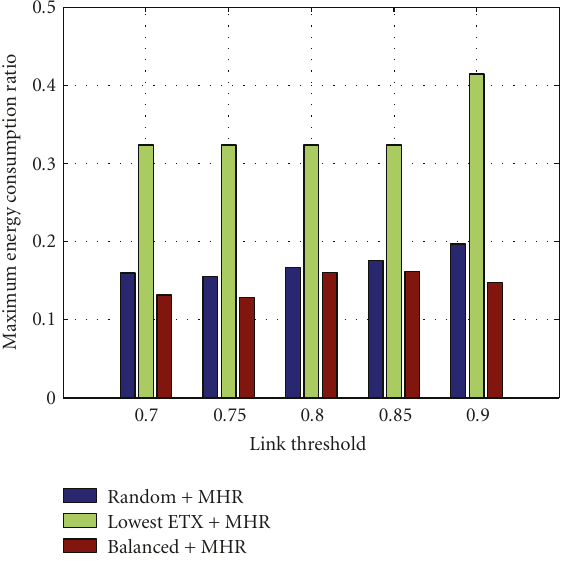
Figure 5: The ratio of the maximum energy consumption of MHR schemes to the maximum energy consumption of the lowest ETX scheme.